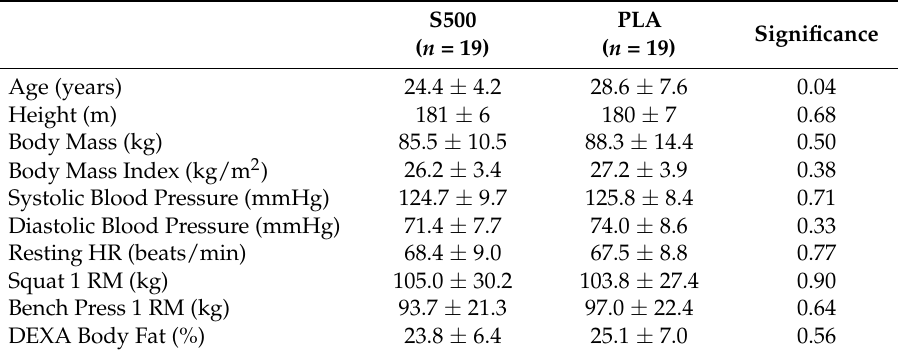
Table 2. Study participant demographics and dietary